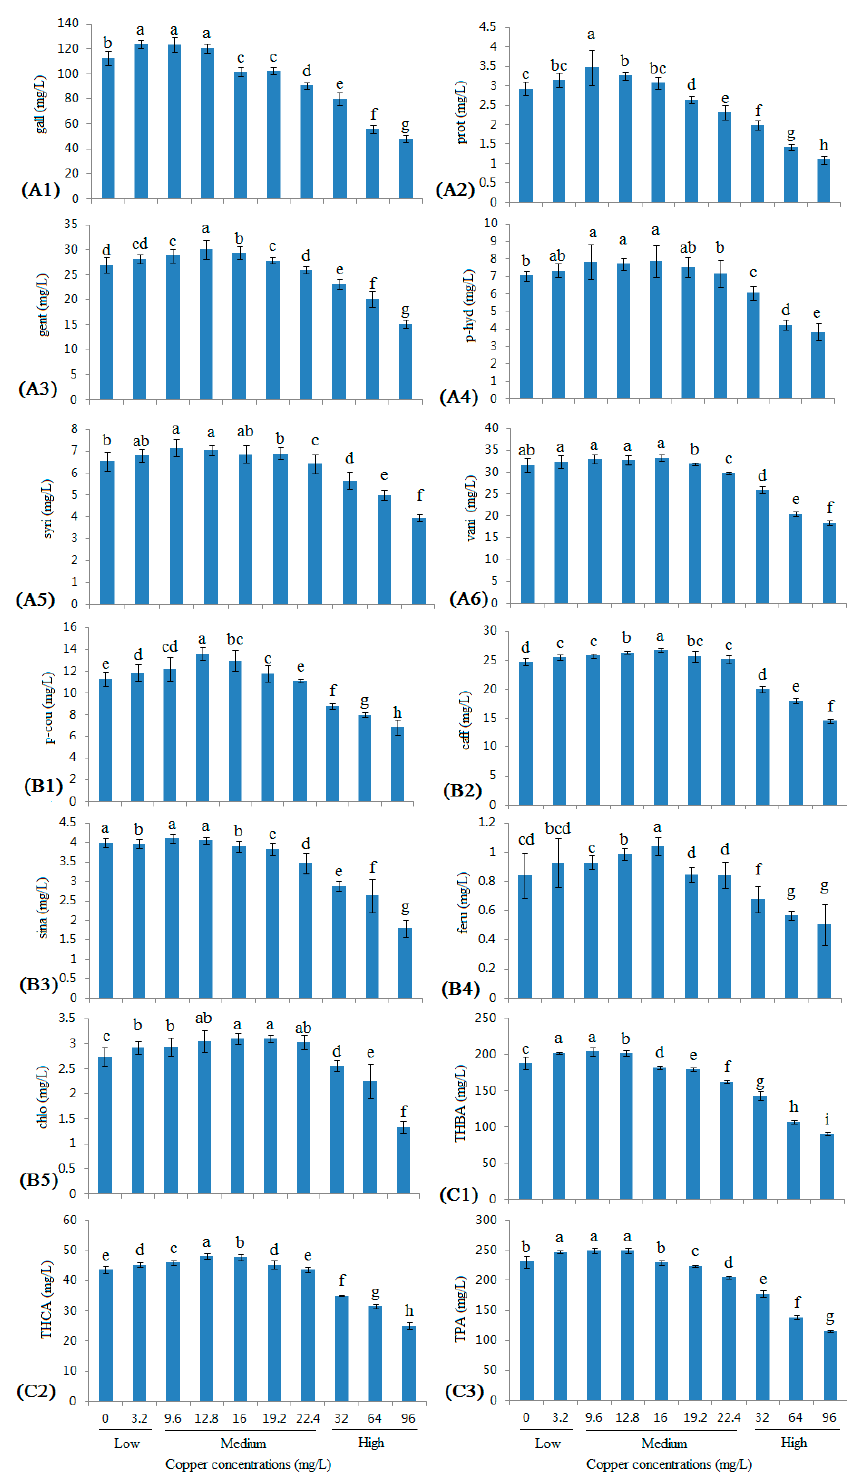
Figure 2. Changes in monomeric phenolic acid contents in wine with different copper concentrations.